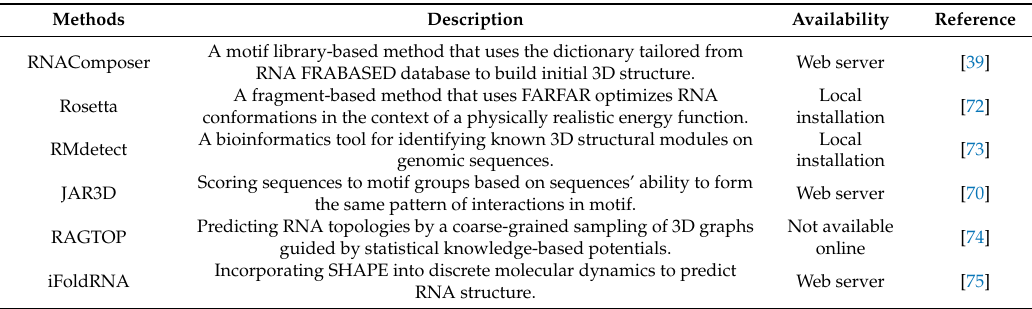
Table 1. Methods which have been used for modeling 3D structure for